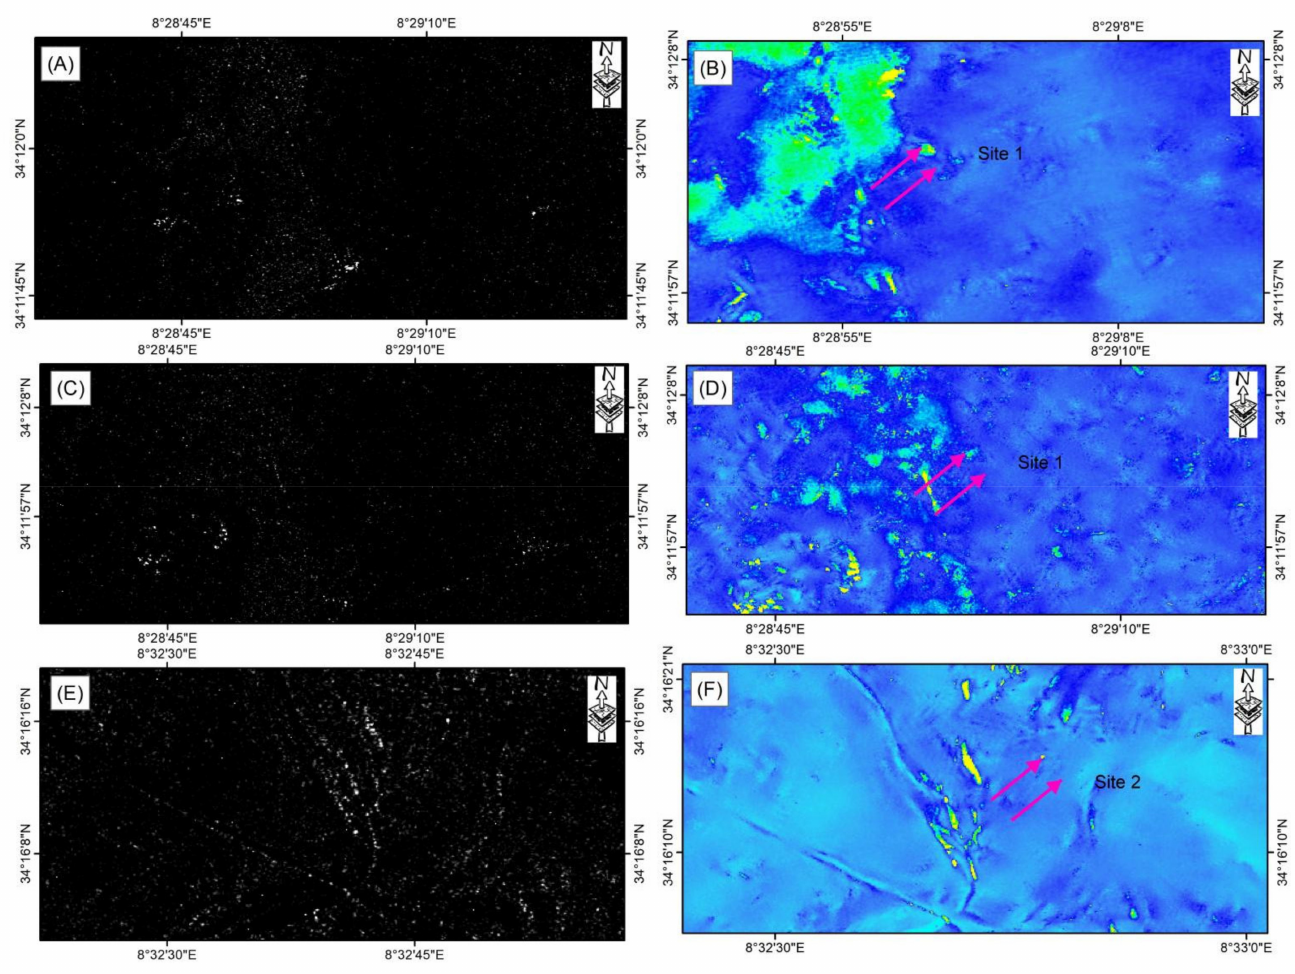
Figure 4. Results obtained with the NL-SAR method involving CSK SL data. ( A – C , E ) Original CSK intensity images: ( A , C ) CSK SL images acquired on 9 February 2018 (SAR image © DLR, 2018) in the independent mode under horizontal–horizontal (HH) polarization; ( E ) CSK SL image acquired on 21 March 2018 (SAR image © DLR, 2015) in the descending mode under HH polarization; ( B , D , F ) corresponding NL-SAR CSK SL images. The pink arrows denote some features of the ancient fortress in the eastern part of the study